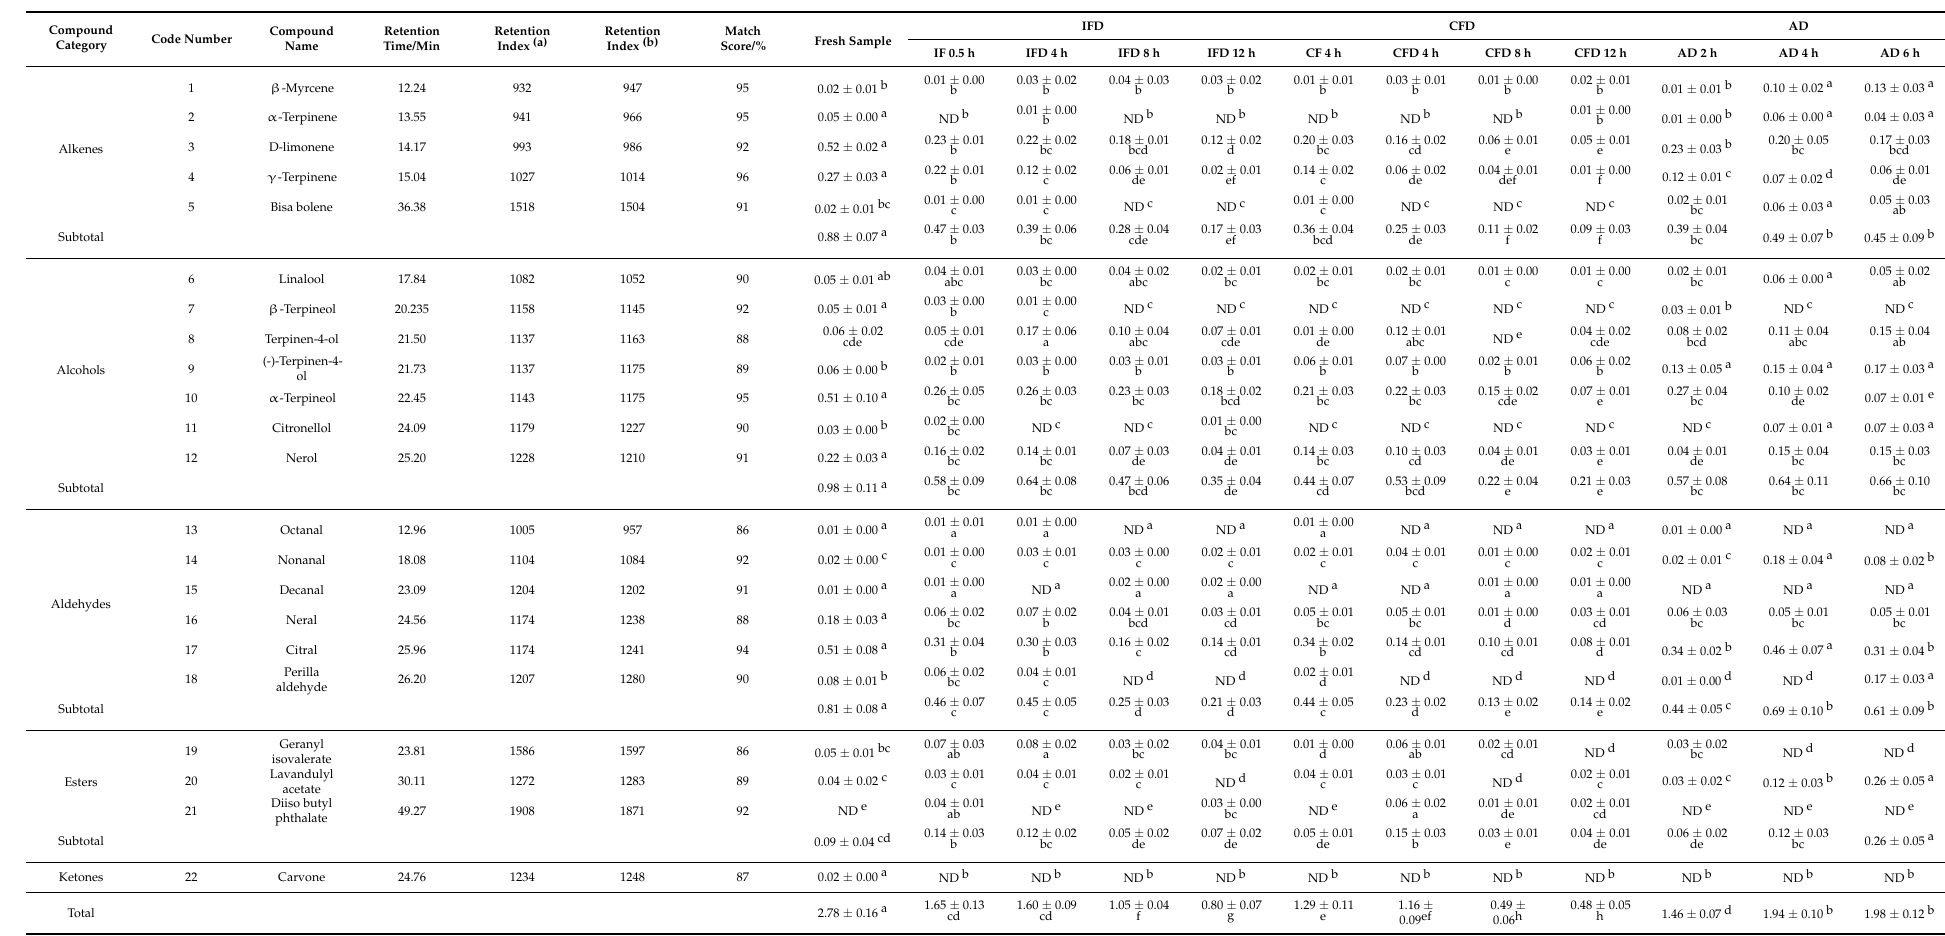
Table 1. Volatile flavor compounds and content of lemon juice vesicles for different drying methods/(mg/g